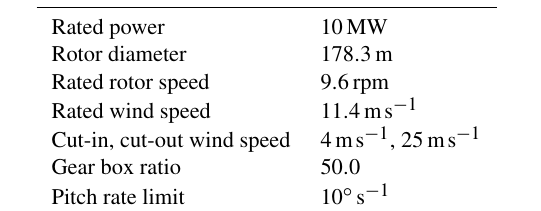
Table 1. Summary of DTU 10MW